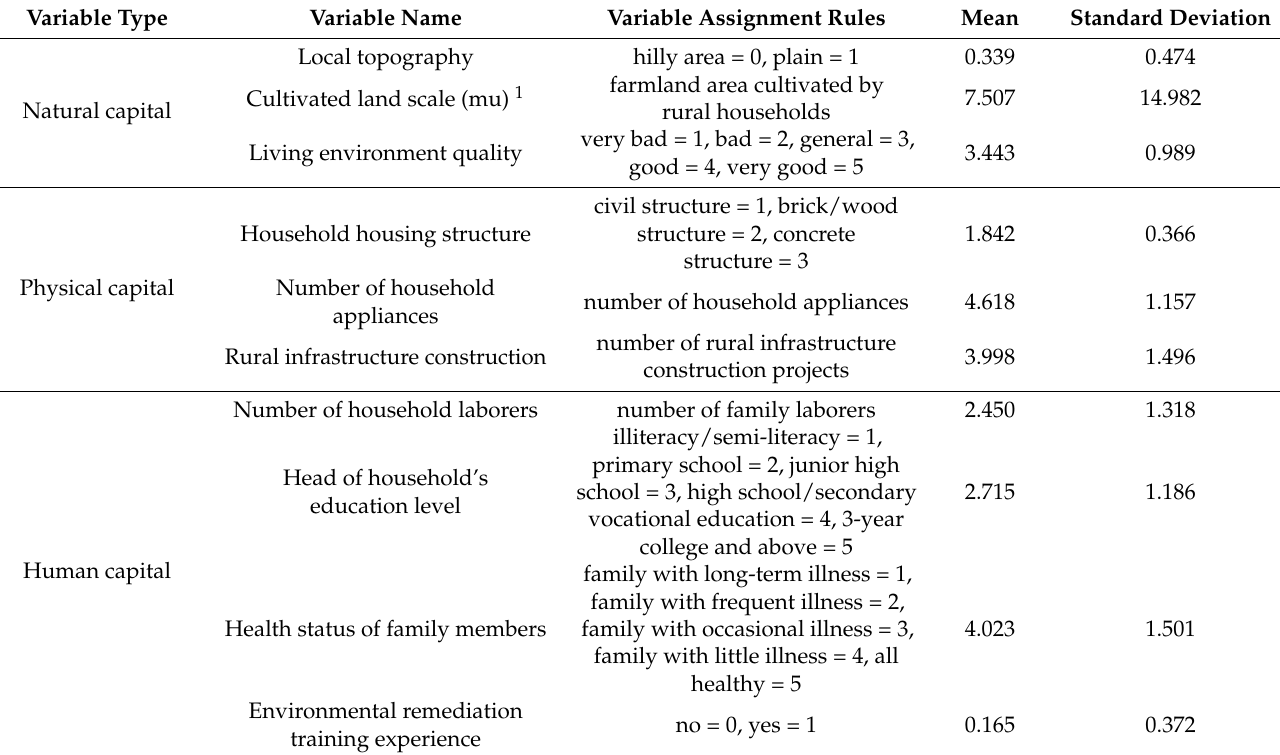
Table 2. Setting and assignment of livelihood capital